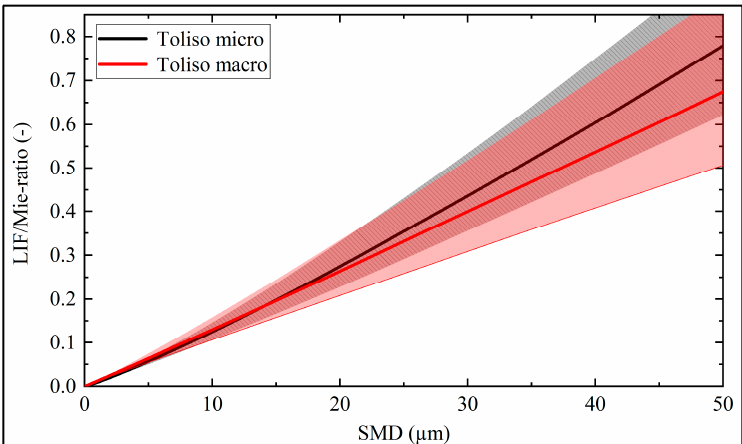
Figure 5. Fitting curve of the experimental data plotted for the LIF/Mie ratio as a function of the droplet diameter for Toliso with their corresponding standard deviations at the reference conditions (293 K, nile red 100 mg/l).